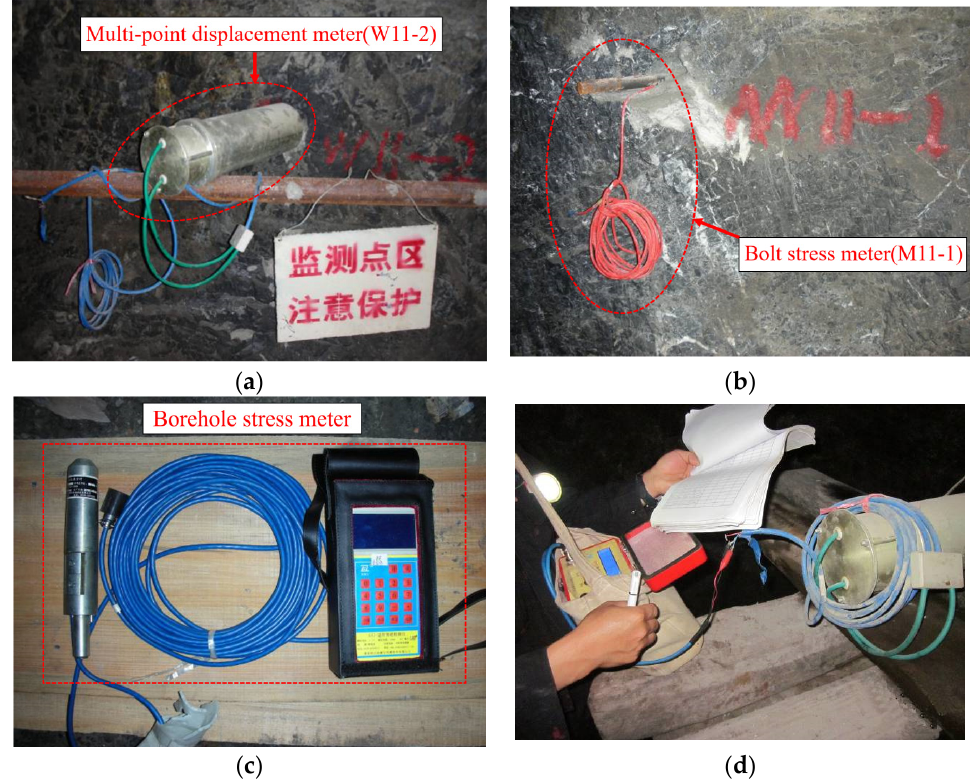
Figure 9. Photographs of the field monitoring instruments, they should be listed as: ( a ) On-site monitoring diagram of the multipoint displacement meter; ( b ) On-site monitoring diagram of the bolt stress meter; ( c ) On-site monitoring diagram of the borehole stress meter; ( d ) The author recording the monitoring data in the field.